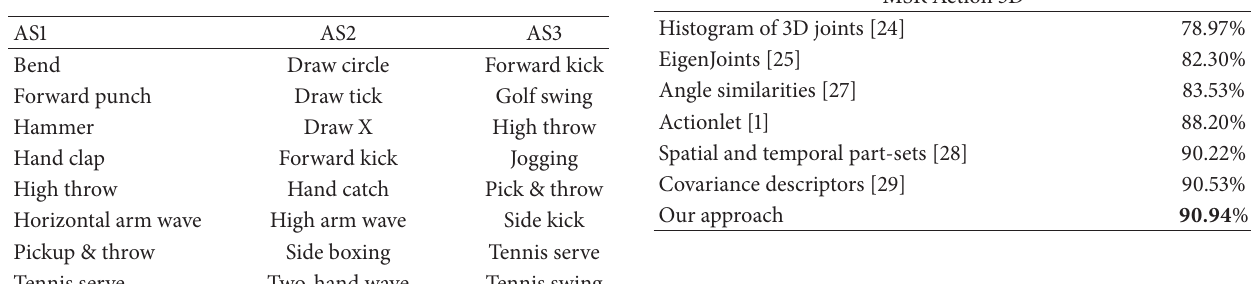
Figure 6: How many key poses does the model need? Table 3: The three subsets of actions used in the experiments.